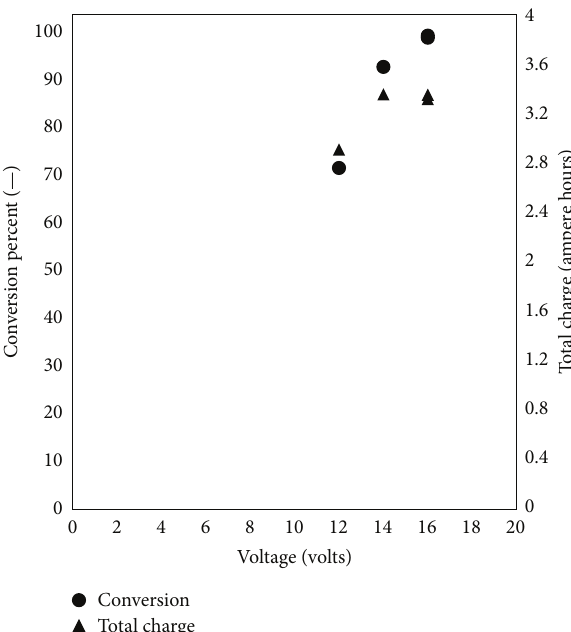
Figure 9: Conversion percent (—) and total charge (ampere hours) versus voltage (volts) for 4 N feed